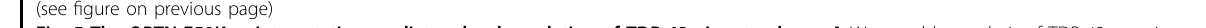
Fig. 5 The OPTN-E50K point mutation mediates the degradation of TDP-43 via autophagy. A Western blot analysis of TDP-43 protein expression in the retinal cytoplasm and nucleus. β -tubulin and histone h3 were used as loading controls to validate the fractionation of cellular extracts. B , C The protein expression of TDP-43 was signi fi cantly greater in the cytoplasm and was signi fi cantly lower in the nucleus in the retinas of E50K mutant mice than in those of WT mice. n = 3. D Fluorescence analysis of the localisation of TDP-43 and optineurin in retinas of WT and E50K mutant mice. TDP-43-positive granules (red) were more colocalized with optineurin signals (green) in E50K mutant mice, and E and F both the values of Pearson ’ s correlation and Manders ’ overlap coef fi cient between OPTN and TDP-43 were signi fi cantly higher in E50K mutant mice than in WT mice.